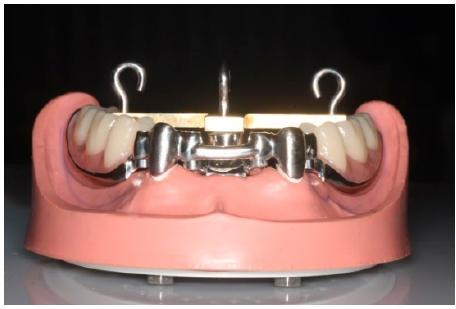
Figure 1. Test model including test prosthesis for conventionally fabricated pairs of double crowns and T-shaped traverse with hook for anchoring to the universal testing machine.